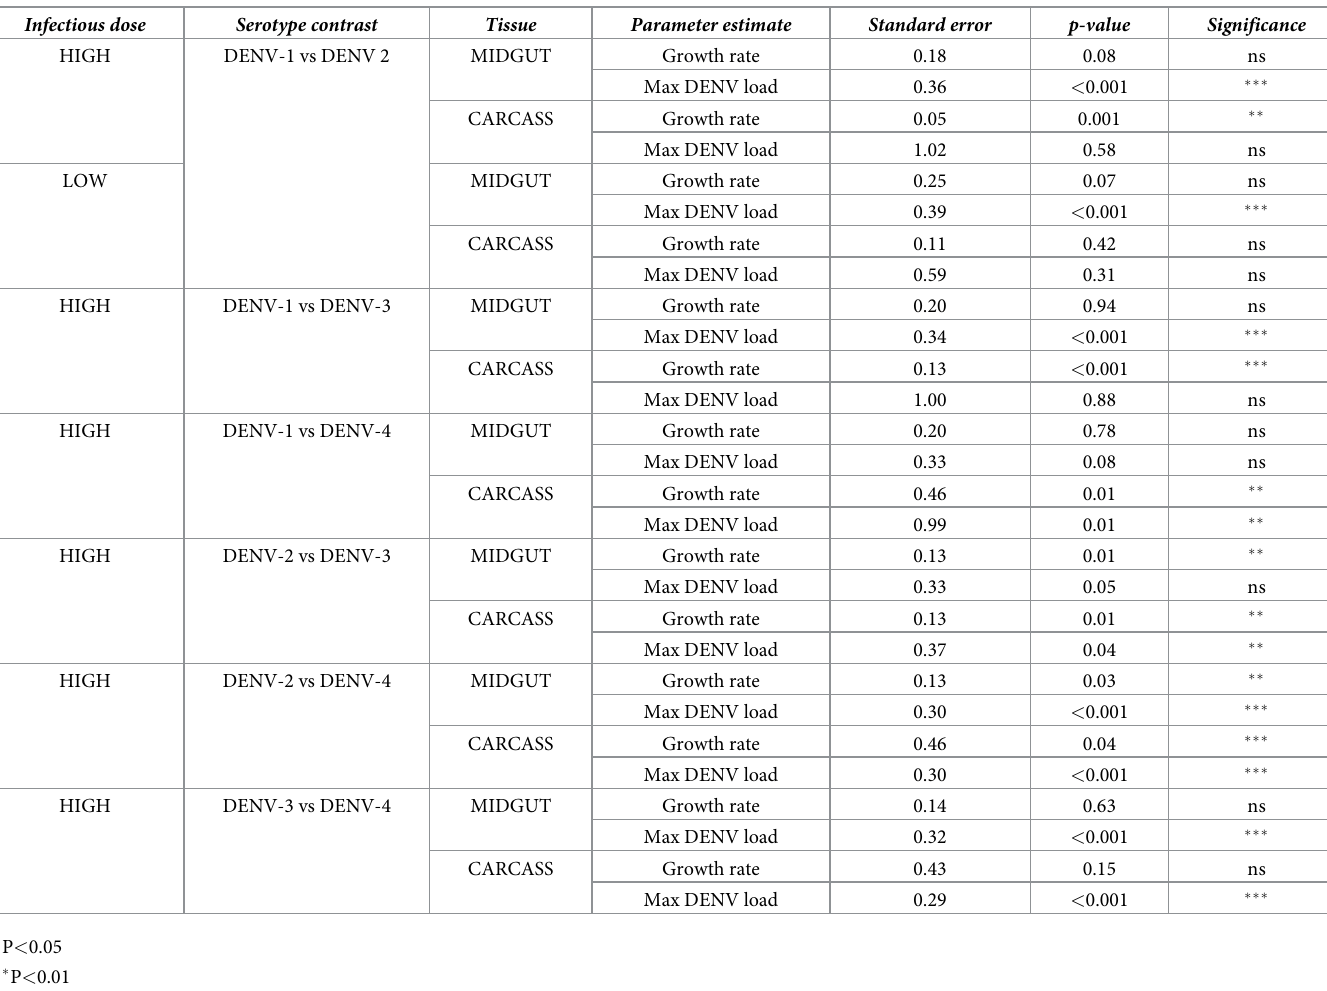
Table 3. DRC parameter contrasts for successful infections between strains, infectious dose and subpopulations. Infectious